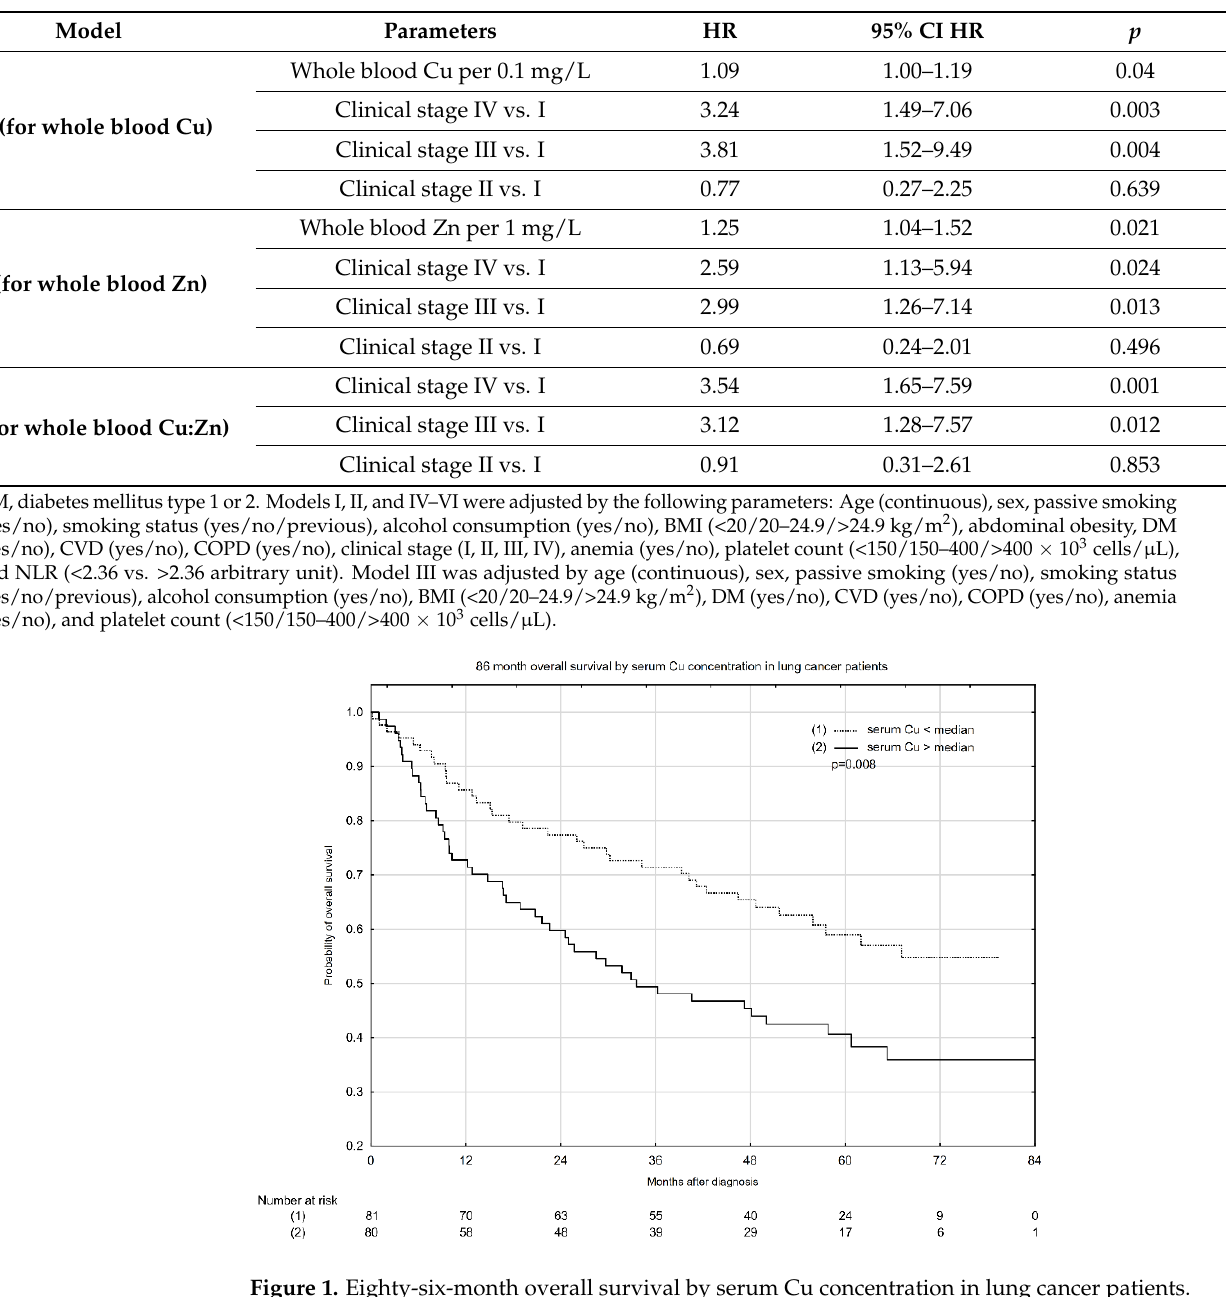
Figure 2. Eighty-six-month overall survival by serum Cu:Zn ratio in lung cancer patients.